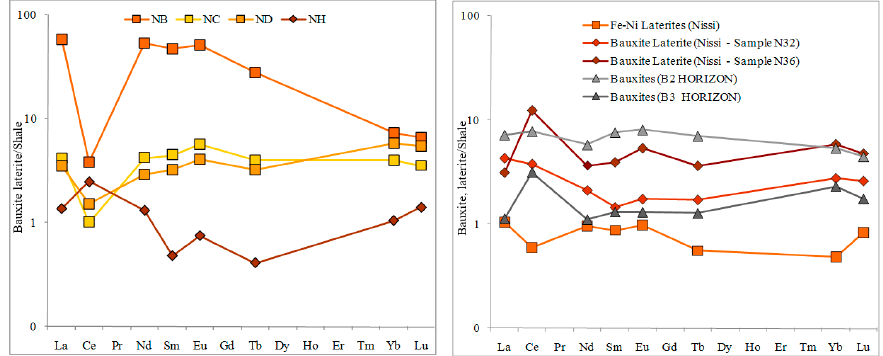
Figure 4. Shale normalized rare-earth elements (REE)-patterns (after Piper, 1974) of Fe–Ni